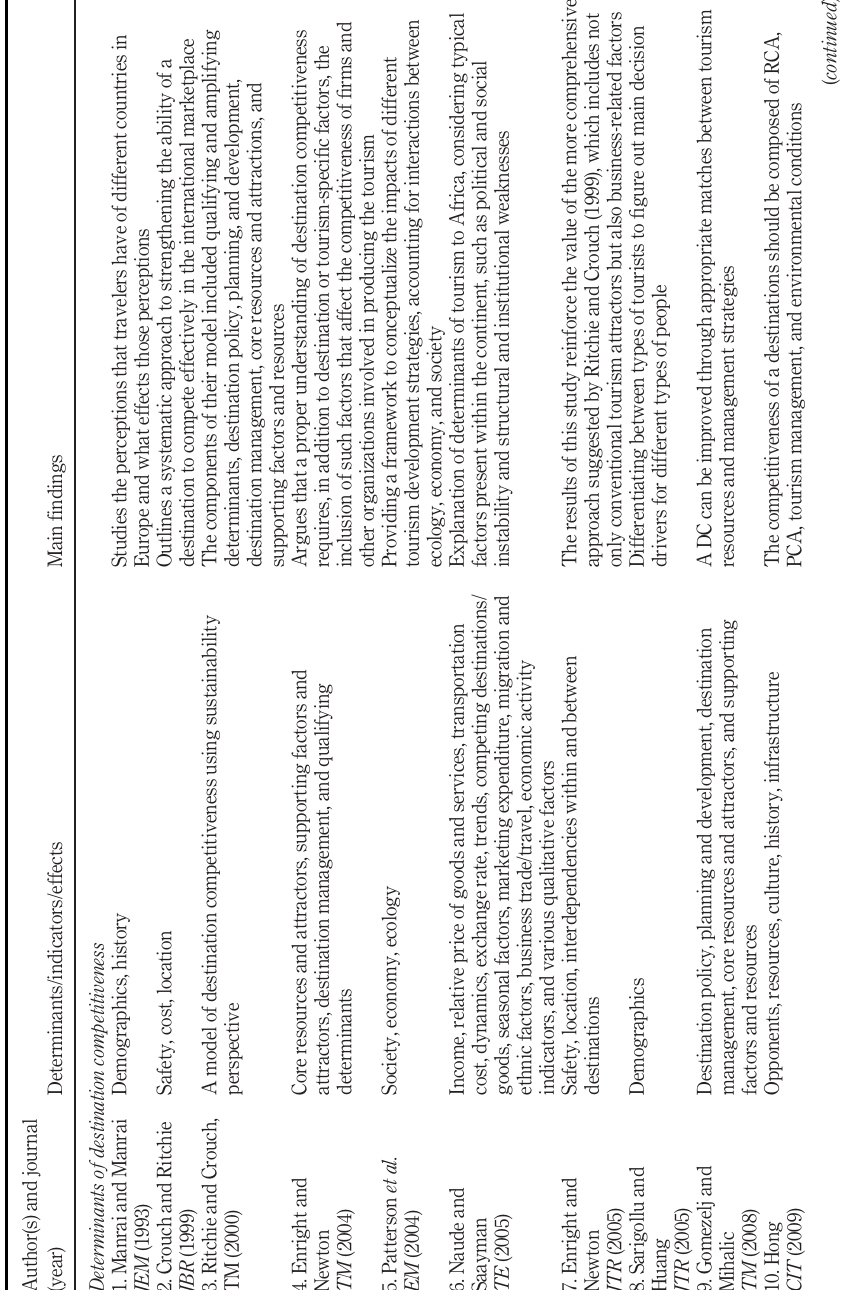
Table I. Summary of literature